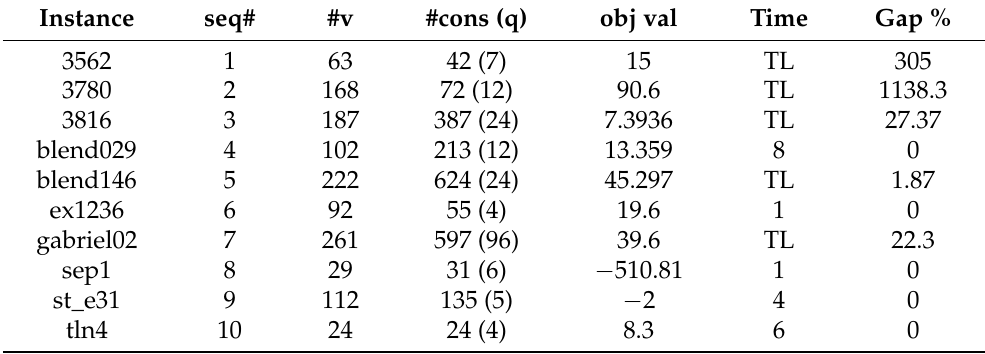
Table 8. Statistics of MIQCP test instances, and the solving results by SCIP.